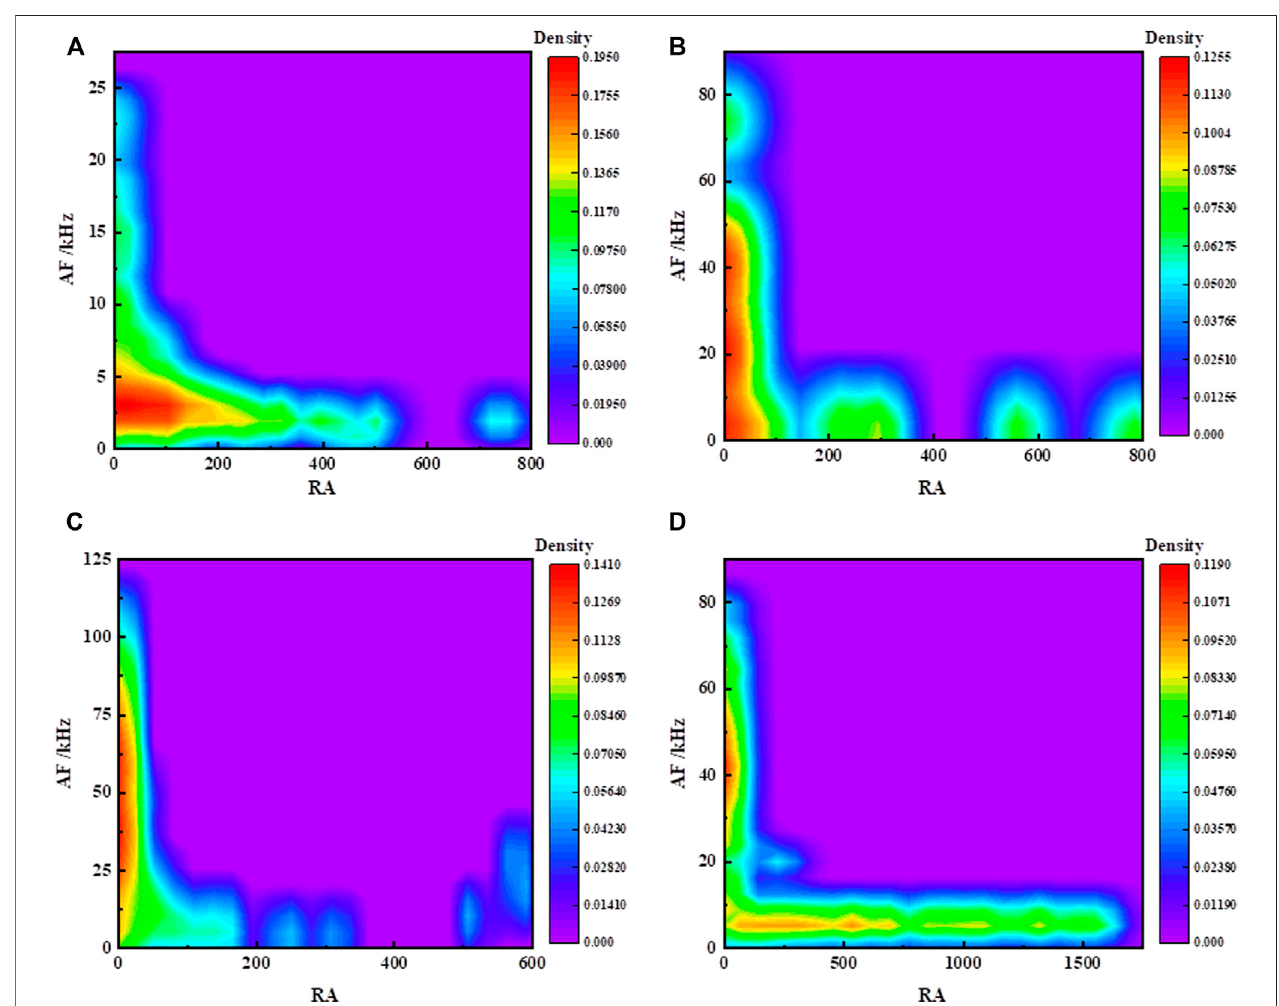
FIGURE 11 | AF-RA data density maps for typical sandstone with different grain sizes under Brazilian splitting (A) medium sandstone, (B) coarse sandstone, (C) siltstone, and (D) fi ne sandstone.